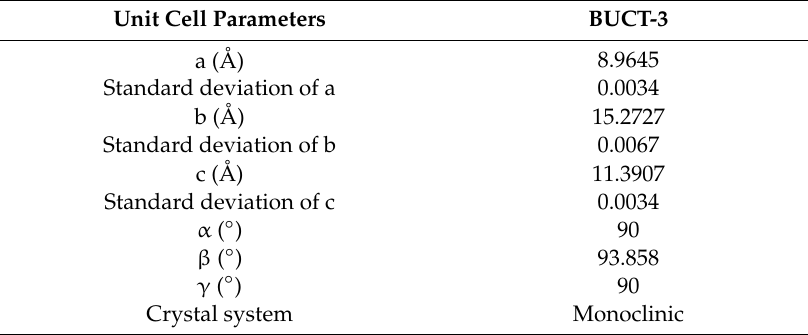
Table 4. The unit cell parameters and crystal system of BUCT-3 molecular sieves by XRD.